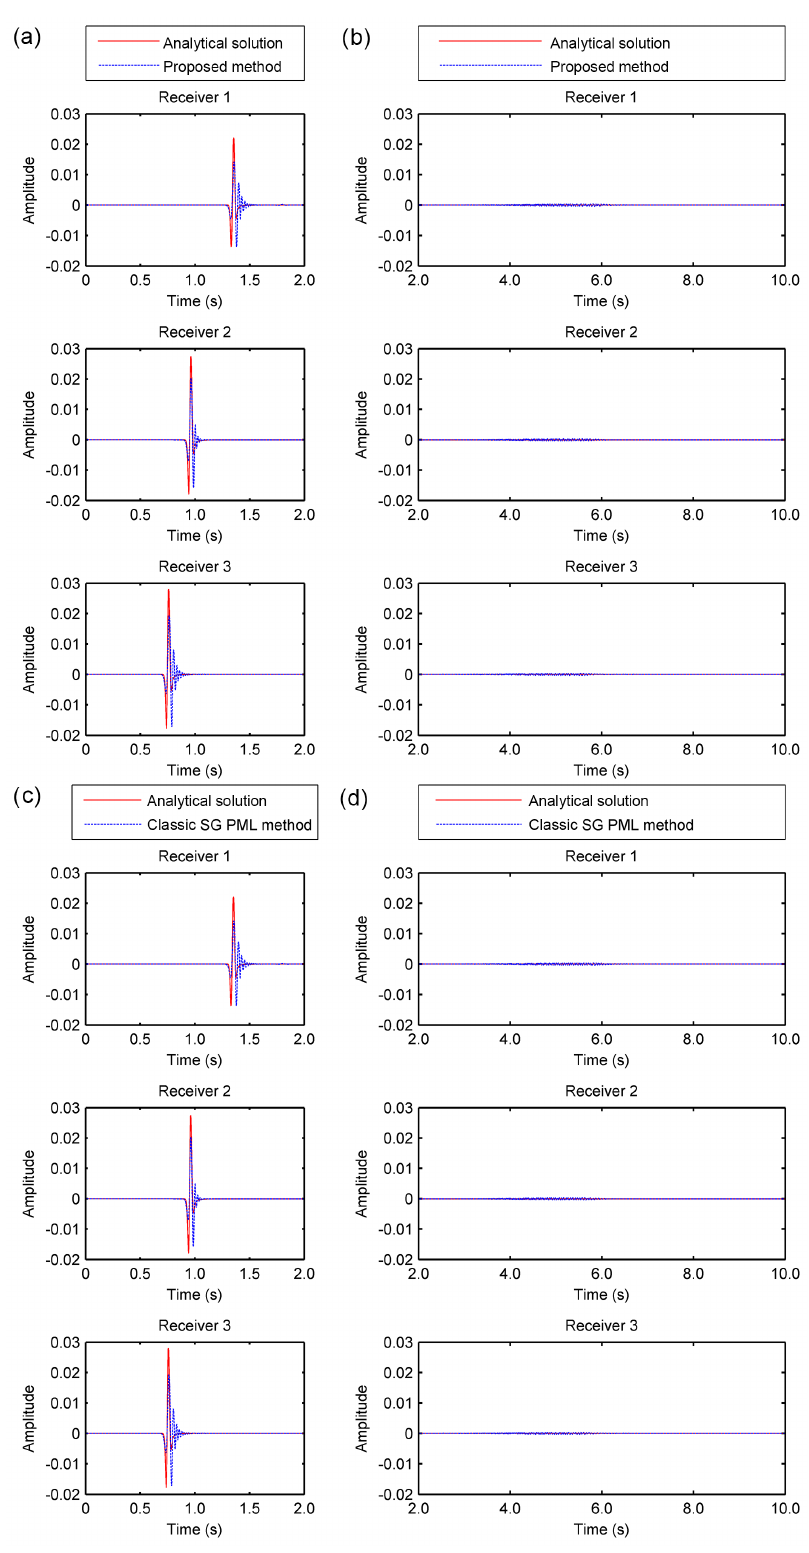
Figure 4. d = 10m; the rest is the same as in Fig. 3.